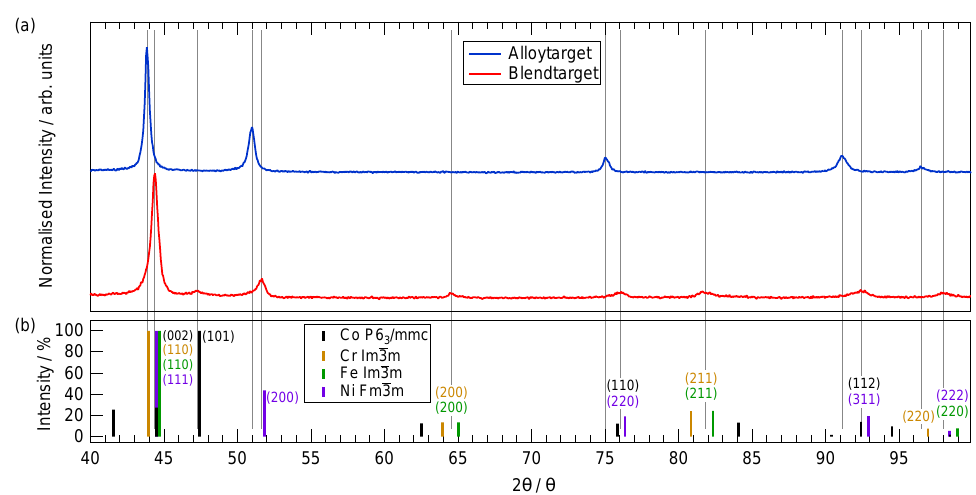
Figure 3. X-ray diffraction data for the Alloytarget (blue) and the Blendtarget (red) ( a ) and expected signals for powder diffraction of pure Co, Cr, Fe and Ni ( b ). The height of the bars represents the expected intensity relative to the most intense signal. Diffraction planes with a corresponding signal in one of the diffraction pattern (vertical lines) are labelled accordingly.